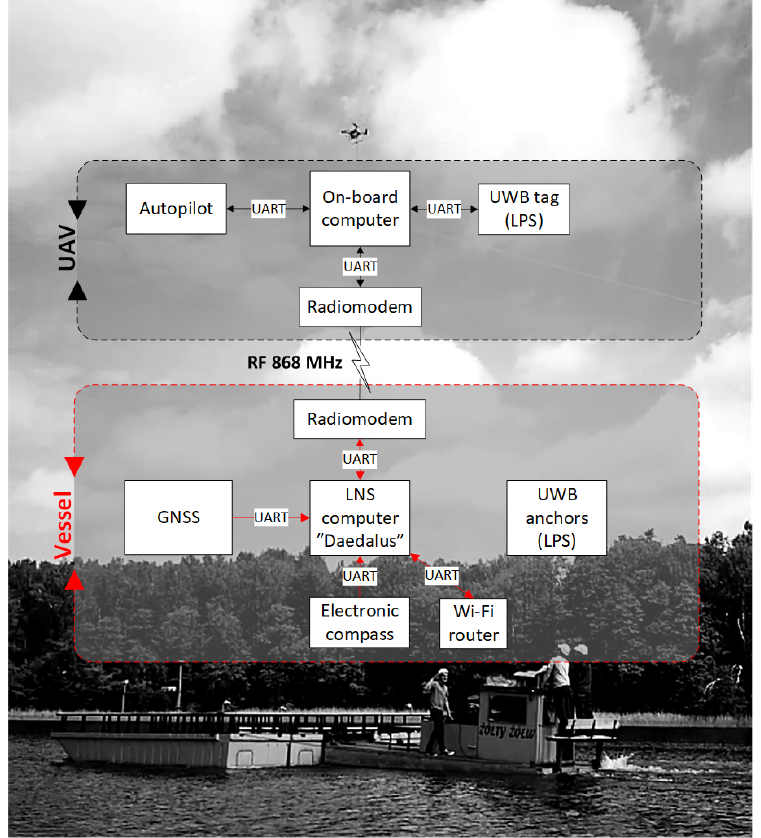
Figure 1. Components of the precision navigation